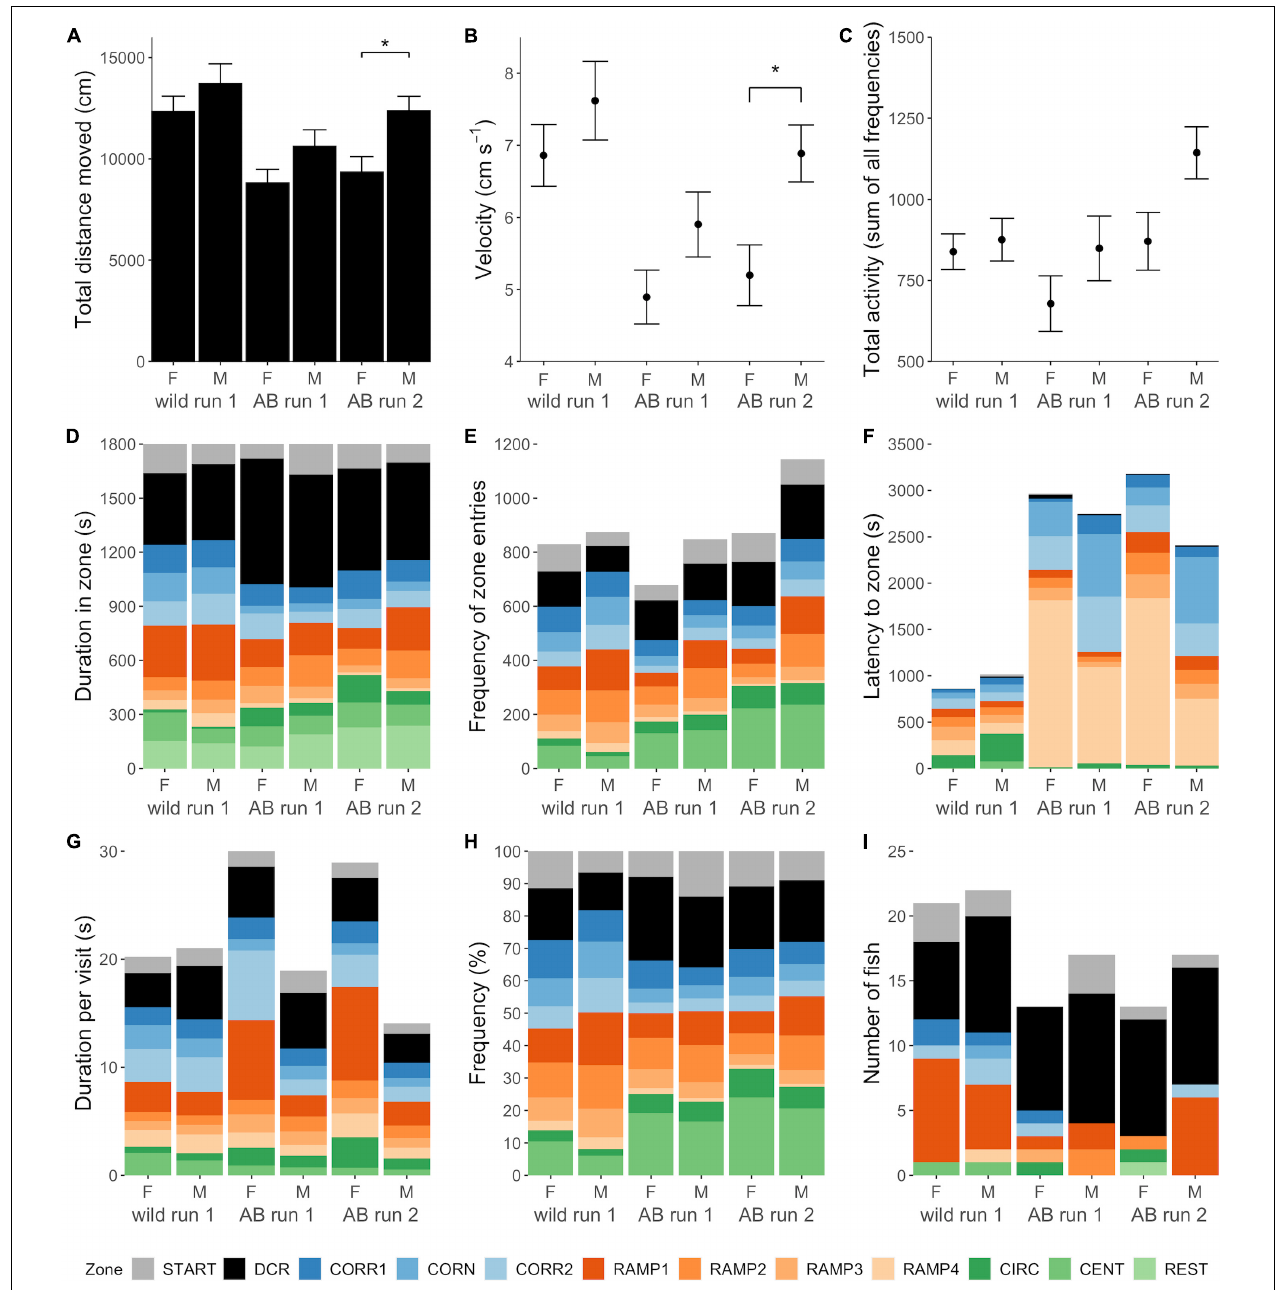
FIGURE 3 | Behavior in the zMCSF test. Locomotory activity variables (A) total distance moved (cm), (B) average velocity (cm s - 1 ) and (C) total activity (sum of all zone entries) per experimental group calculated for the whole arena. In (A–C) , the height of the bars or points represents the mean ± SEM per group. Brackets with stars (*) indicate statistically significant differences ( p < 0.05) between experimental groups; main effects of Strain, Sex, and Run are shown in Supplementary Table 1 . (D–I) Present zone related variables (D) duration (s) in zone, (E) frequency of zone entries, (F) Latency (s) to zone, (G) average duration per visit (s), (H) percentage of zone entries, and (I) the number of fish that had a certain zone as its home base. For example, the majority of AB females in run 1 had the DCR as their home base, so the DCR was zone that the fish spent the longest cumulative duration in. In (D–I) , the height of each colored bar represents the mean per zone except for (F) , where these represent median latency (the more accurate summarizing statistic for this variable). For the REST zone, only duration could be quantified. Note that this figure combines the “strain” and “retested” datasets which were analyzed in two separate models per response variable, see methods section “Statistical Analyses.” CENT, center; CIRC, central circle; CORN, corner; CORR, corridor; DCR, dark corner roof; REST, the part of the arena not designated to any other zone; F, female; M, male.